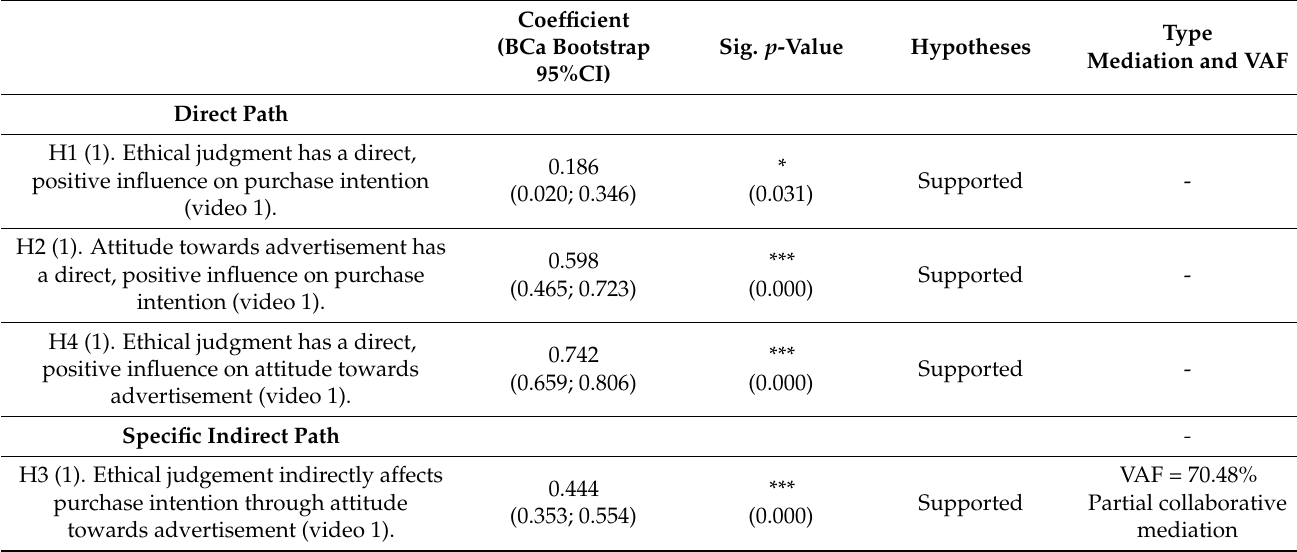
Figure 2. Estimated models (videos 1 and 2). Source: p -values into brackets, adapted from original figures obtained using [79]. Table 2. Direct, indirect, total effect, type of mediation, and results of tests concerning video 1 (hostile